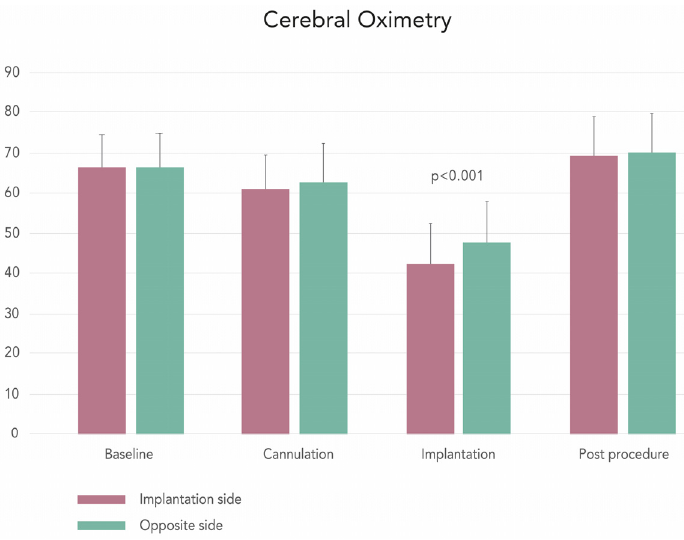
Figure 2. Cerebral oximetry.